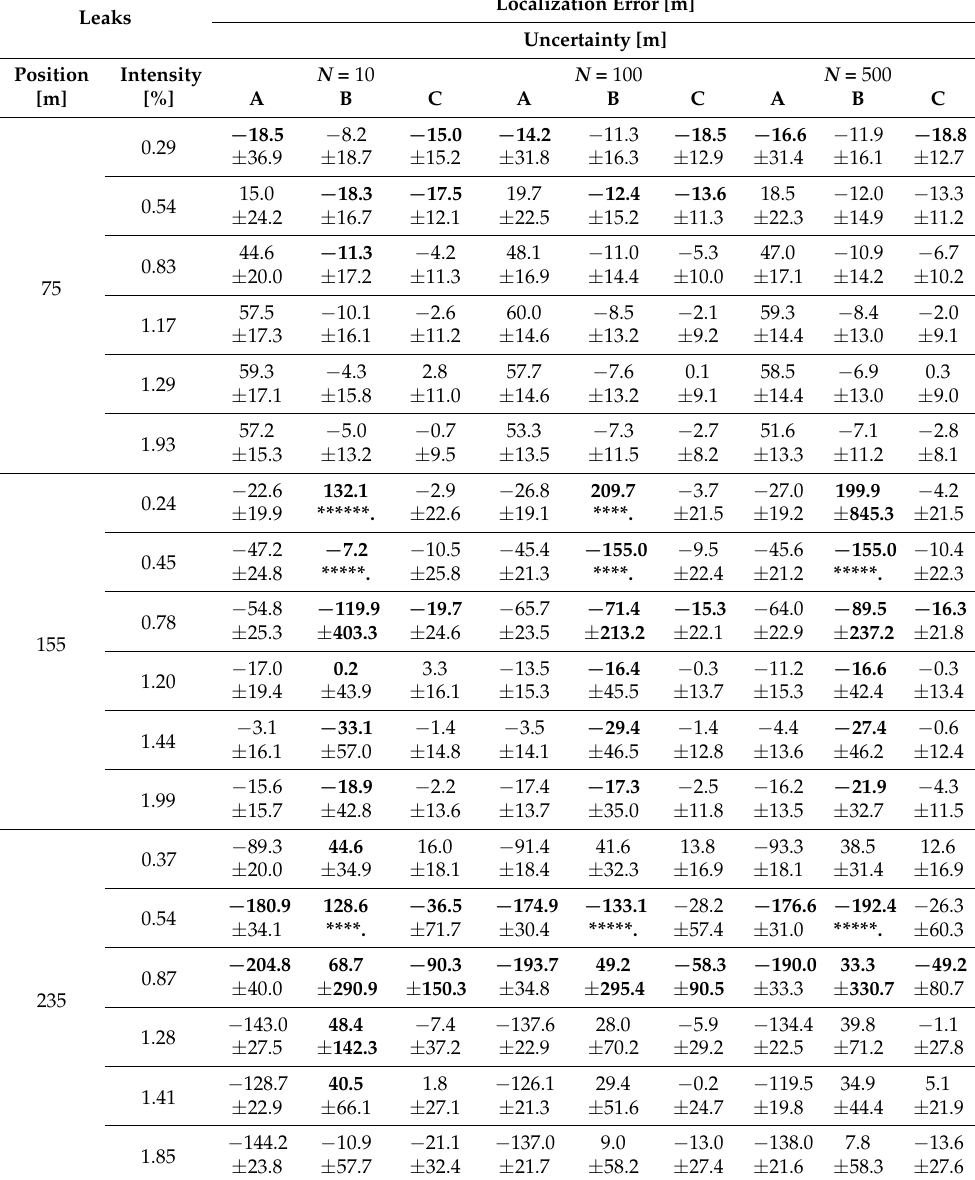
Table 2. Localization errors and uncertainties depending on the position and intensity of a leak, including the different number N of data samples used for pressure estimation, as well as following the sensor configuration A, B or C in the localization procedure. The following meaning is assigned to the marks: bold font—results go beyond the coordinates of the extreme sensors or are outside the pipeline; asterisks—the uncertainty achieves unreasonable high